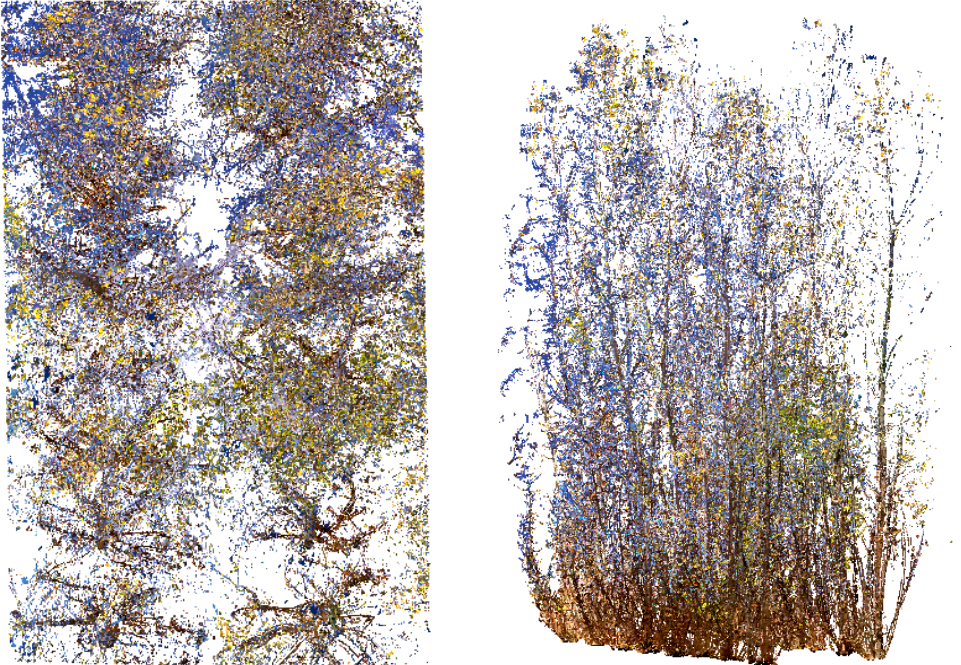
Figure 3. Example of TLS data acquired from the FARO Focus 3D M70 scanner in one of the study plots: overhead view ( left ) and side view ( right ) showing detail from the studied stools.